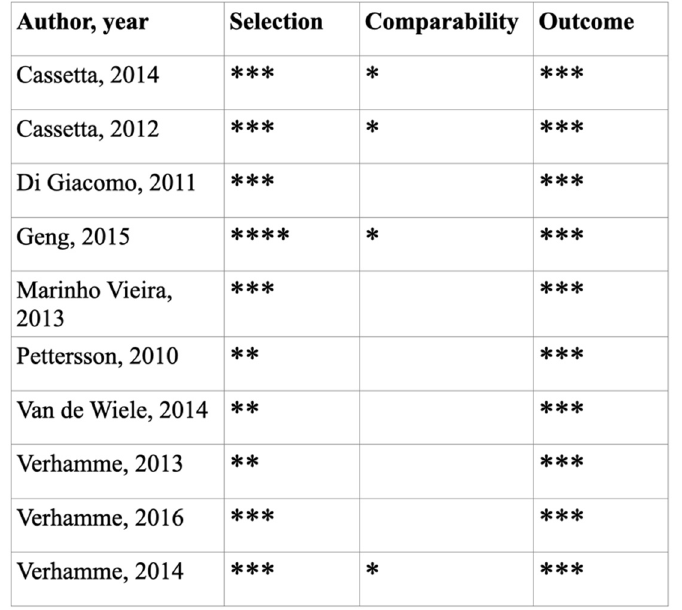
Figure 4. Quality assessment of the included studies following the Newcastle–Ottawa Scale for assessing the quality of nonrandomized trials. (Good quality: 3 or 4 *; Fair quality: 2 *; Poor quality: 0 or 1 *)